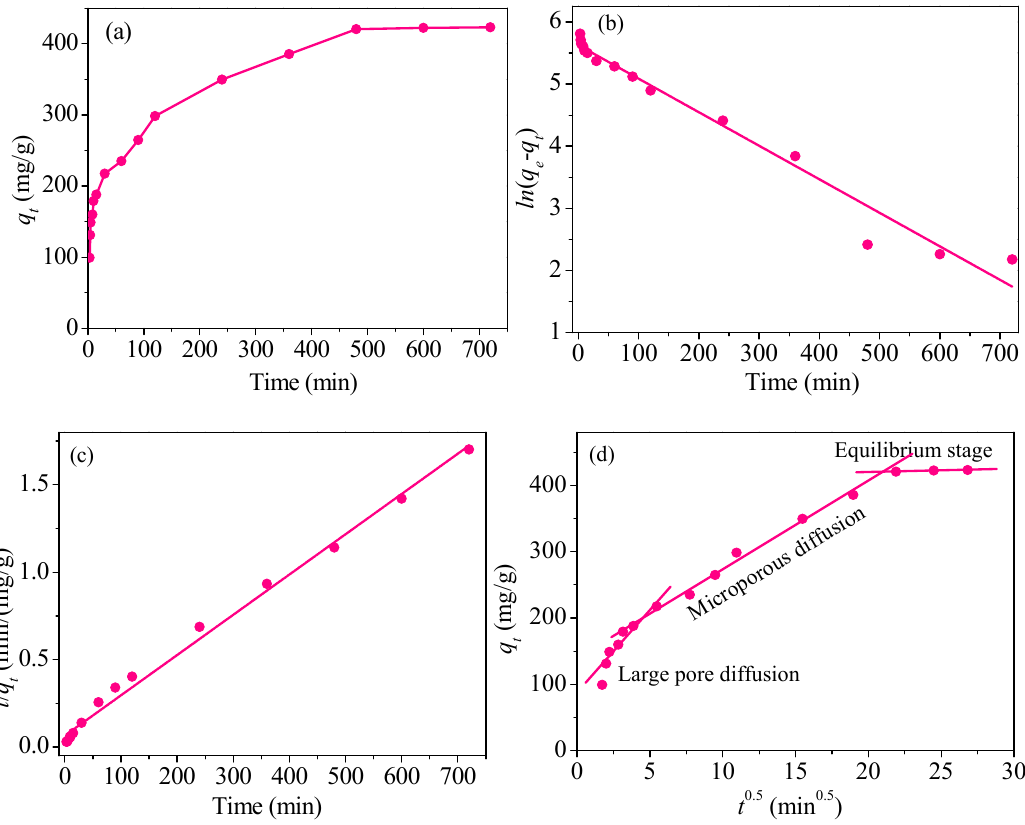
Figure 12. ( a ) Effect of contact time; results of ( b ) pseudo-first-order, ( c ) pseudo-second-order and intraparticle ( d ) intraparticle diffusion.